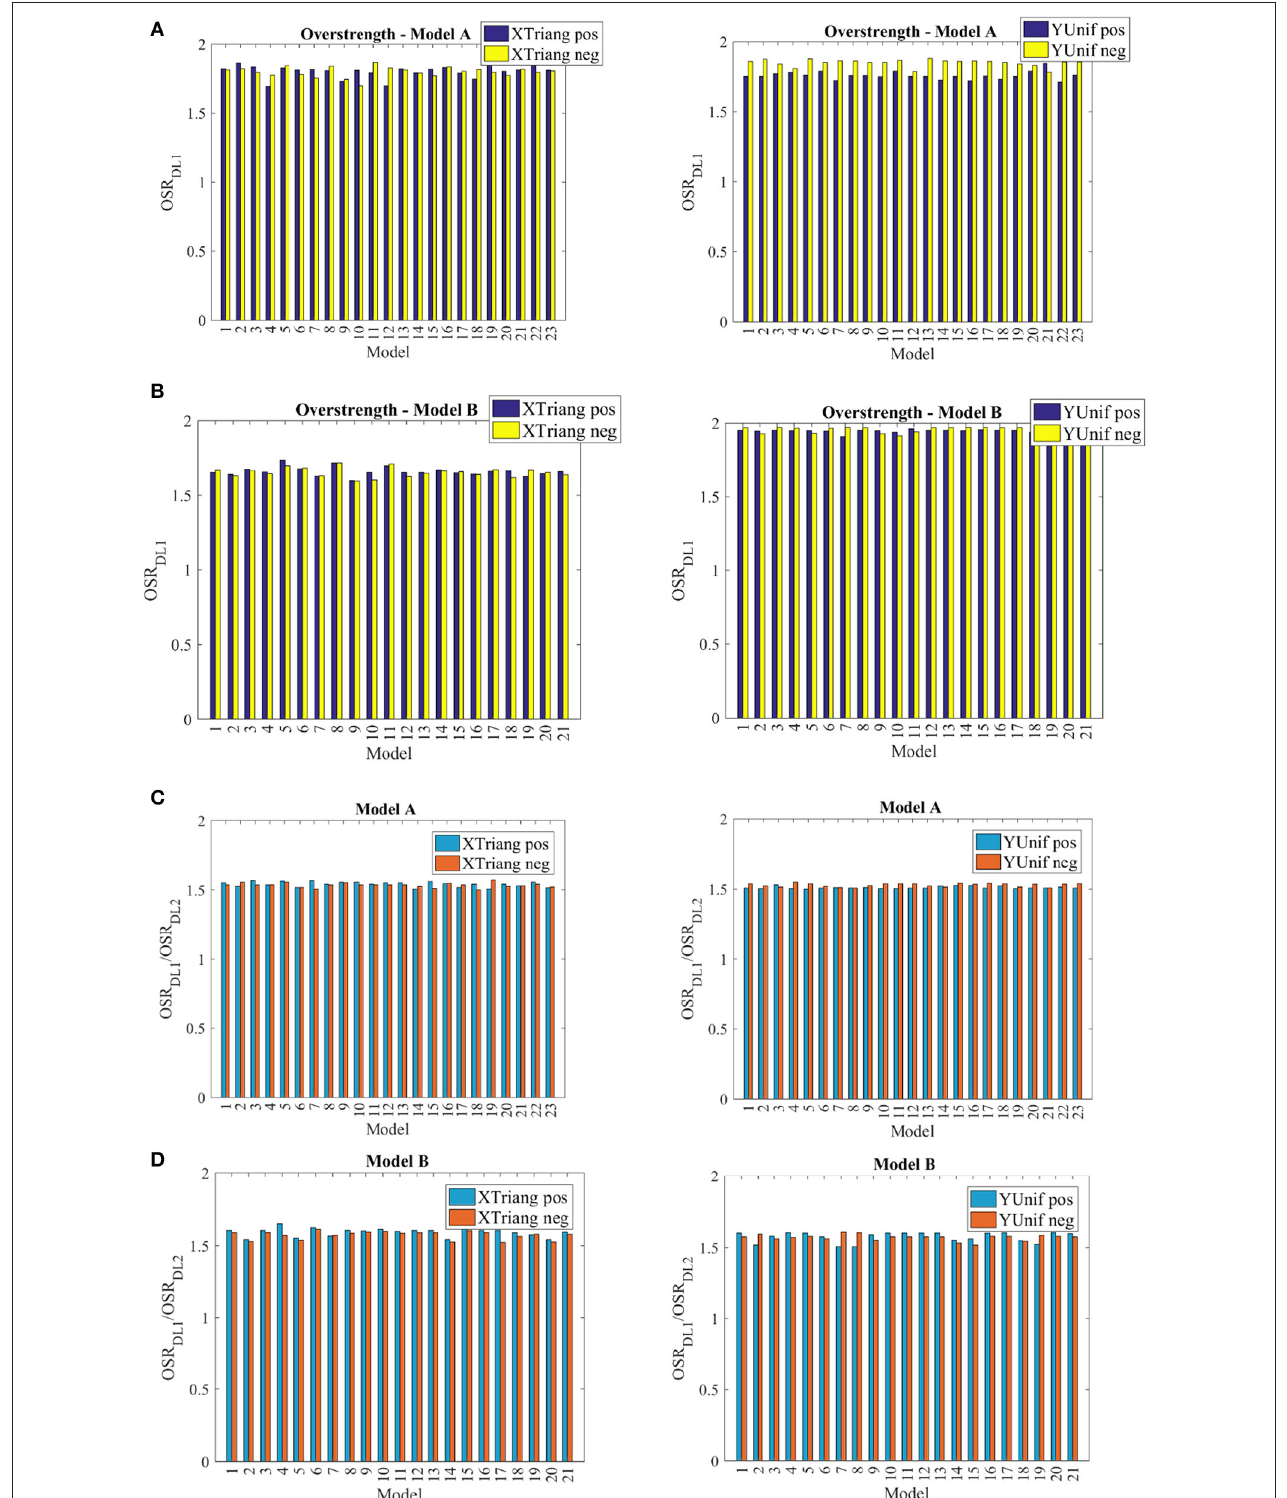
FIGURE 15 | Overstrenght for X and Y direction for Model A (A) and Model B (B) adopting DL1 and ratio between the overstrength defined for DL1 and DL2 for X and Y direction in case of Model A (C) and Model B (D) .